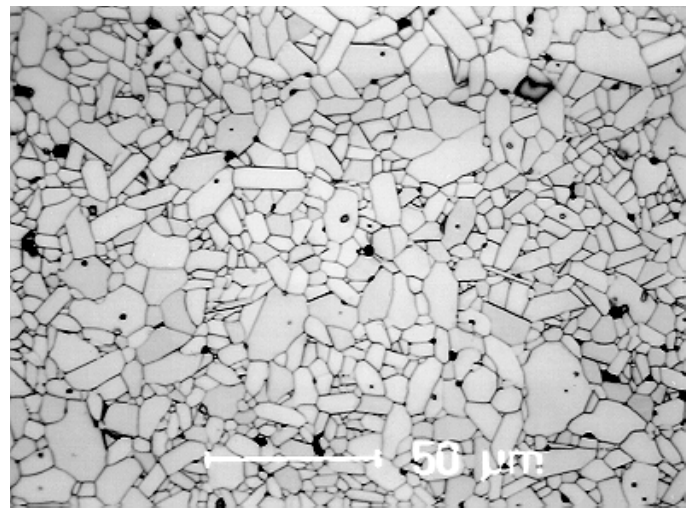
Figure 2. Microstructure of 99.7% alumina based on purified and milled electro corundum.